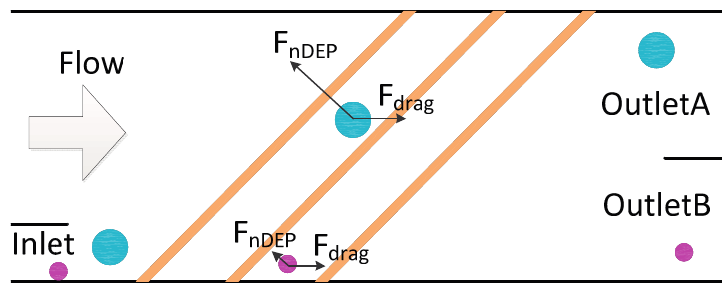
Figure 9. Schematic diagram of lateral separation.